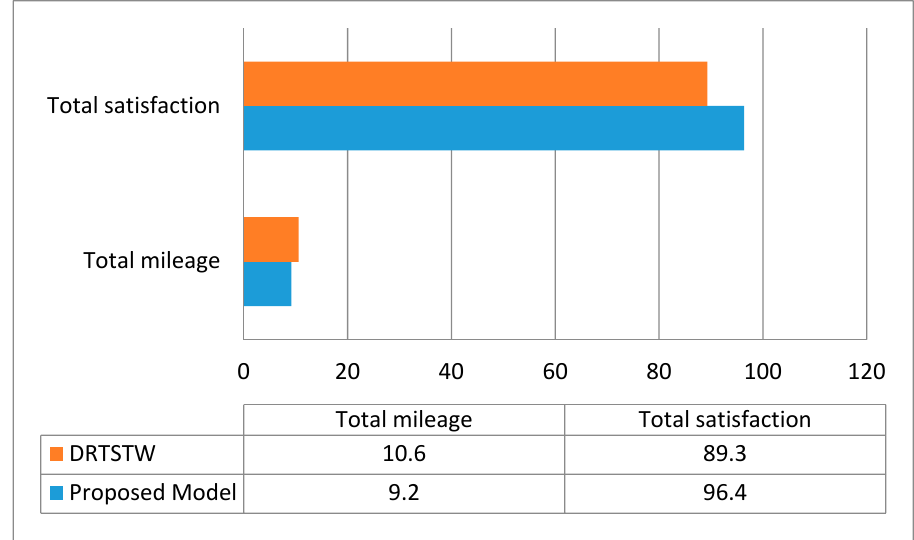
Figure 4. Result comparison of proposed model and traditional DRTs.